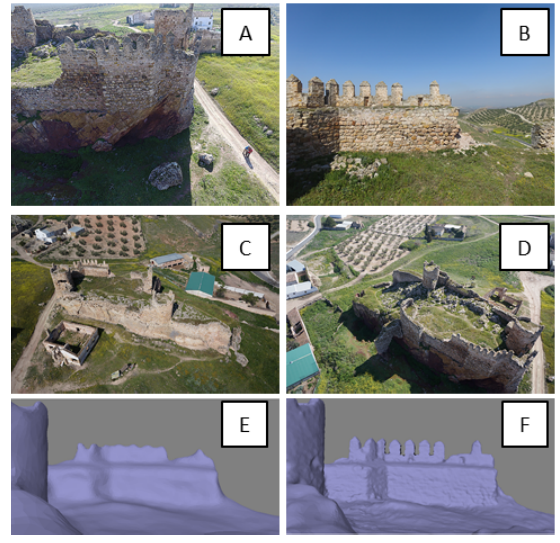
Figure 20. A, B: close range images from the Phantom DJ flight in manual image-acquisition mode; C, D: oblique aerial images from the Falcon 8 in autonomous flight and cruising acquisition mode; E: initial solid model built from the Falcon 8 flight; F: solid model after merging both point clouds and final